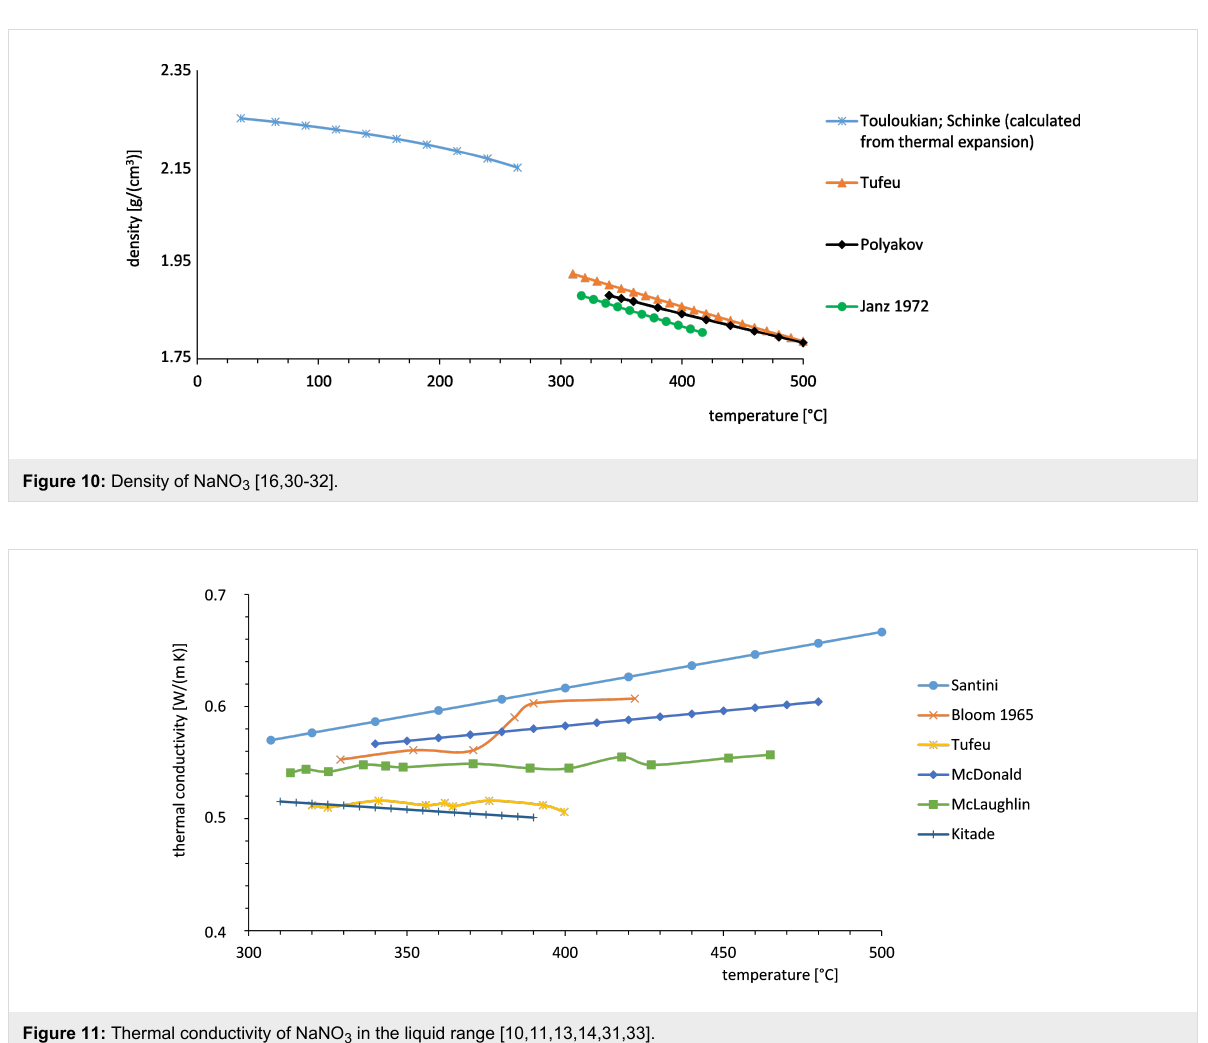
Figure 11: Thermal conductivity of NaNO 3 in the liquid range